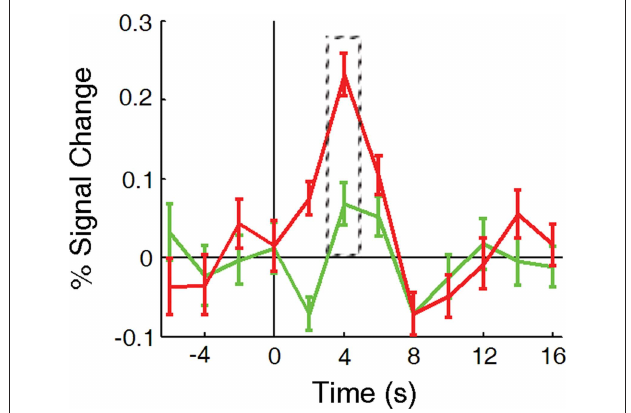
FIguRe 3 | event-related time course, measured in percent signal change, for Distractor Present (red line) and Distractor Absent (green line) trials, taken from area V1. The dashed box around the time points at 4 s indicate the points used to calculate the difference in the peak response to the various events within different cortical regions.